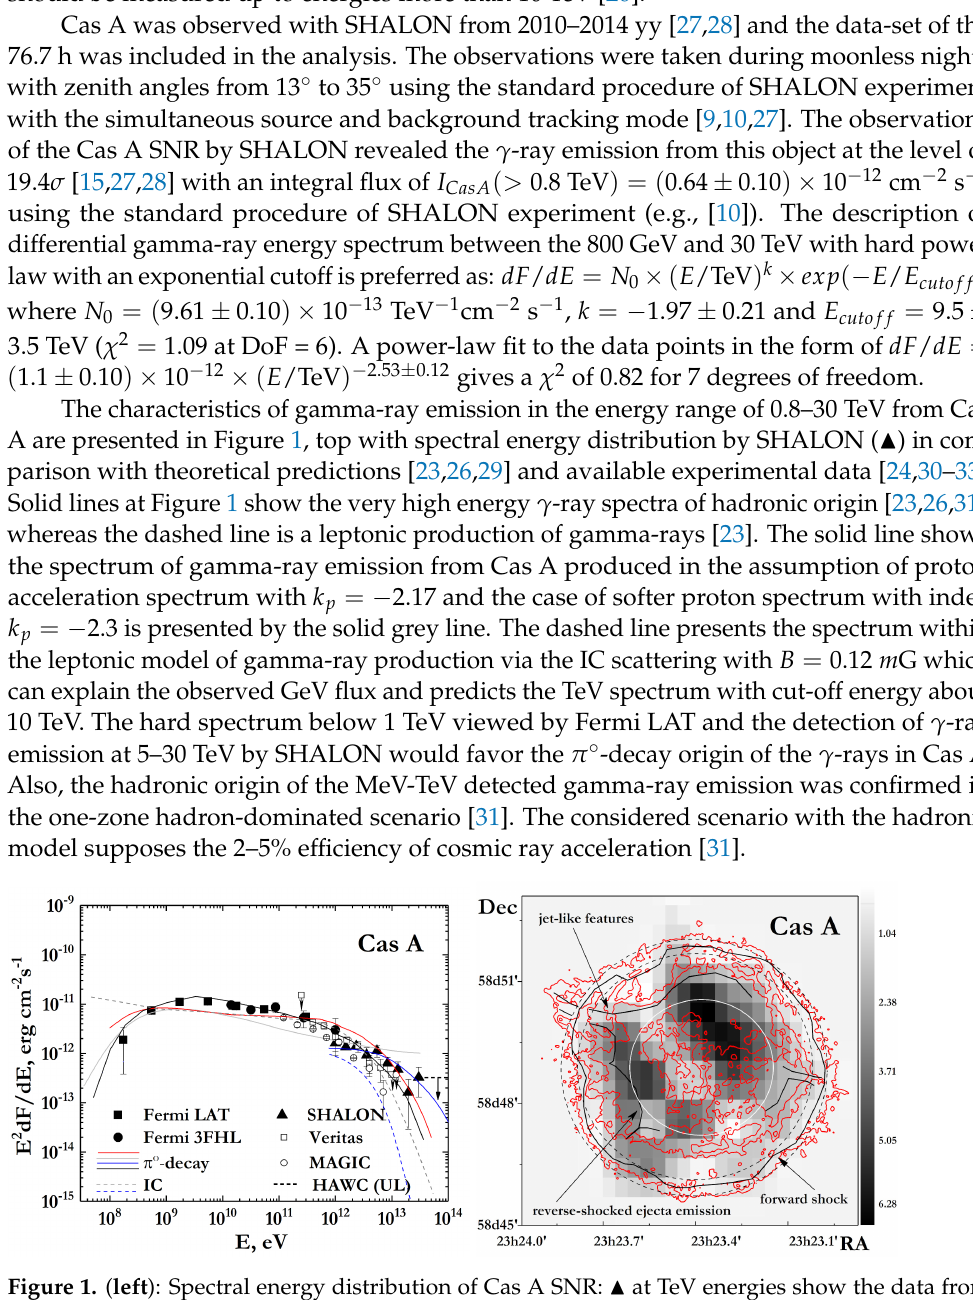
Figure 1. ( left ): Spectral energy distribution of Cas A SNR: (cid:78) at TeV energies show the data from SHALON observations. ( right ): Emission maps of SNR by SHALON (grey scale). Red lines show the X-ray emission by Chandra (see text for the